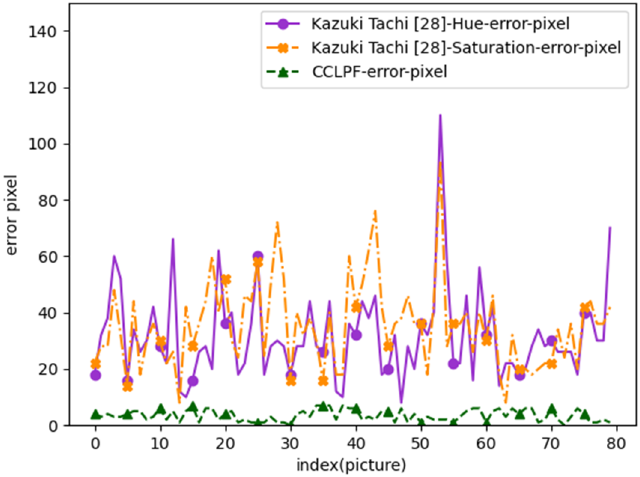
Figure 54. Measurement errors for Data Set 1.